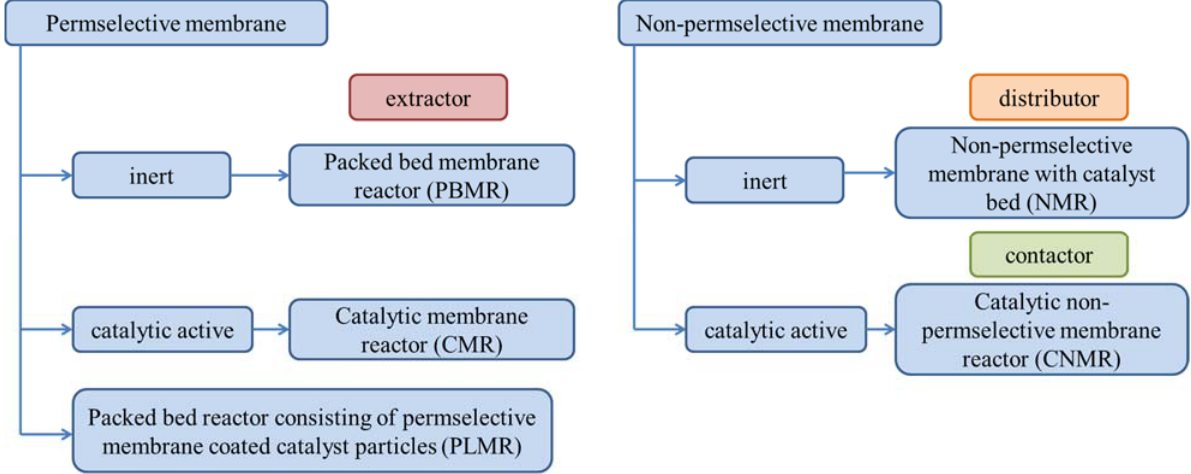
Figure 3. Classification of membrane reactor configurations according to membrane function, after conventional classifications